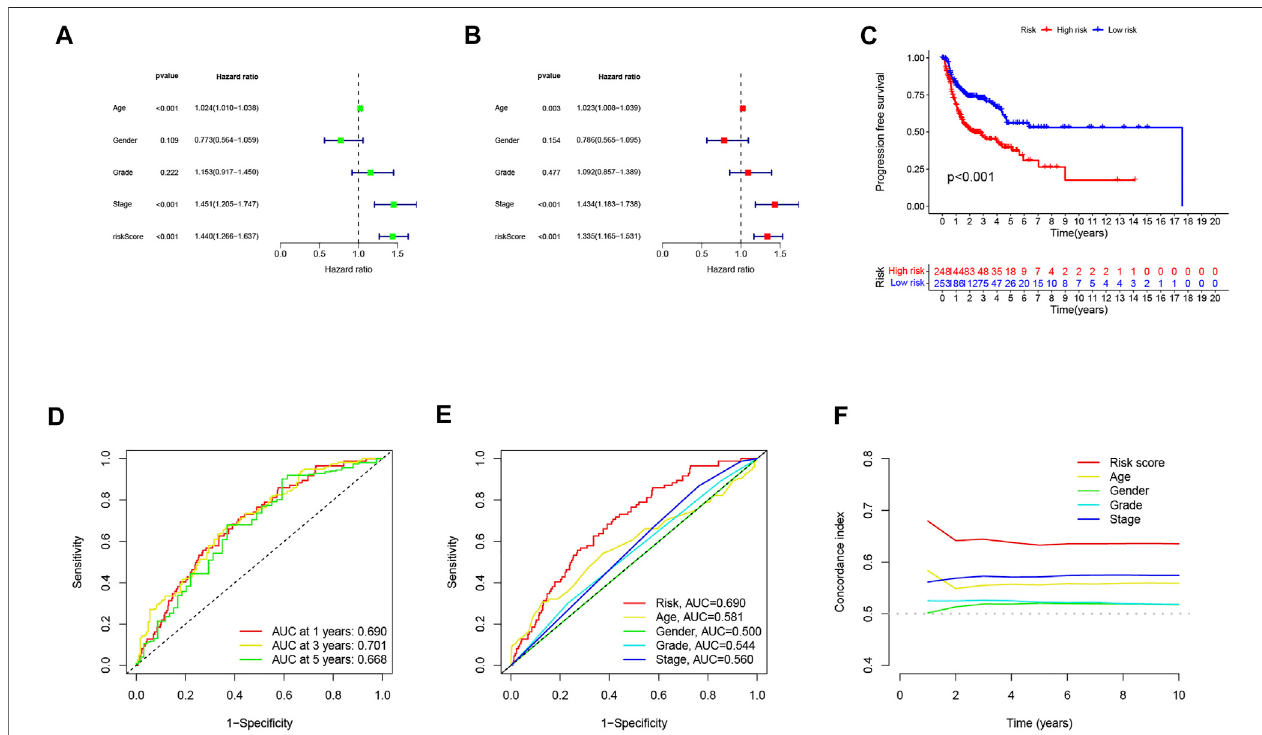
FIGURE4| Independent prognostic analysis ofhead and neck squamous cell carcinoma (HNSC) overall survival(OS). (A) univariate Coxanalysis.Age, stage, and risk score were statistically signi fi cant. (B) multivariate Cox analysis. Age, stage, and risk score were statistically signi fi cant. (C) Kaplan – Meier curves of progression-free survival(PFS). (D) TimeROCcurvepredicted1,3,and5yearsofOSforHNSCpatients. (E) ROCdemonstratedthepredictiveaccuracyoftheriskmodelwassuperiorto other clinical parameters. (F) C-index showed the predictive accuracy of the risk model was superior to other clinical